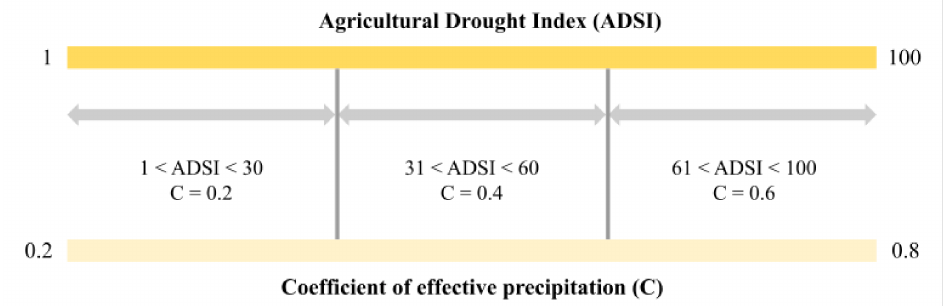
Figure 3. The weighted average of ADSI between 2003 and 2008.